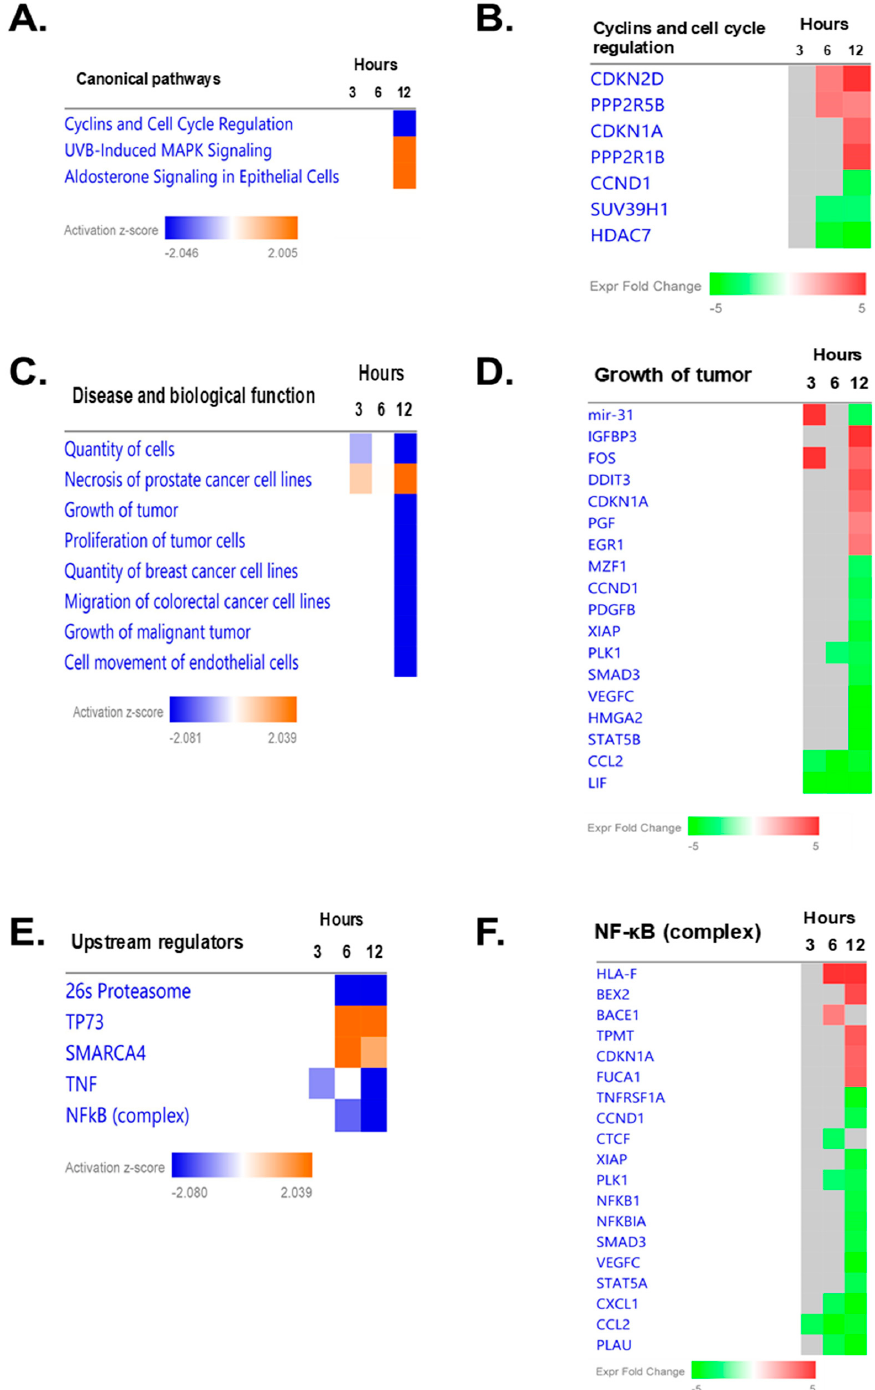
Figure 5. Ingenuity pathway analyses (IPA) of gene expression changes in Panc-1 cells. ( A ) IPA canonical pathways. ( B ) Heatmap of genes in the top canonical pathway (cyclins and cell cycle regulation). ( C ) IPA disease and biological functions. ( D ) Heatmap of genes in the growth of tumor disease and biological function. ( E ) Top 5 IPA upstream regulators. ( F ) Heatmap of genes in NF- κ B complex, which displayed a strong time dependence. ( A , C , E ) The canonical pathways, the disease and biological functions, and the upstream regulators were ranked by Z-scores and the Benjamini–Hochberg ( B – F ) p -value score of the enrichment score. The color scheme and bar are based on activation Z-scores, with activation in orange, inhibition in blue, and undetermined direction in white. ( B , D , F ) The heatmaps showing differentially expressed genes at 3, 6, and 12 h, related to the canonical pathways, the disease and biological functions, and the upstream regulators, respectively. Color bar: expression fold change relative to matched DMSO